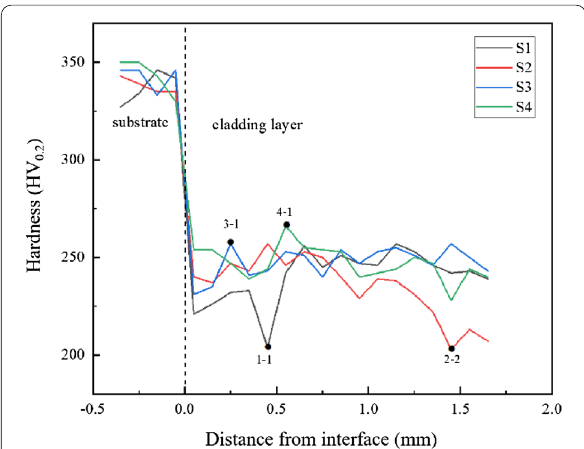
Figure 10 Distribution of hardness value along vertical section direction